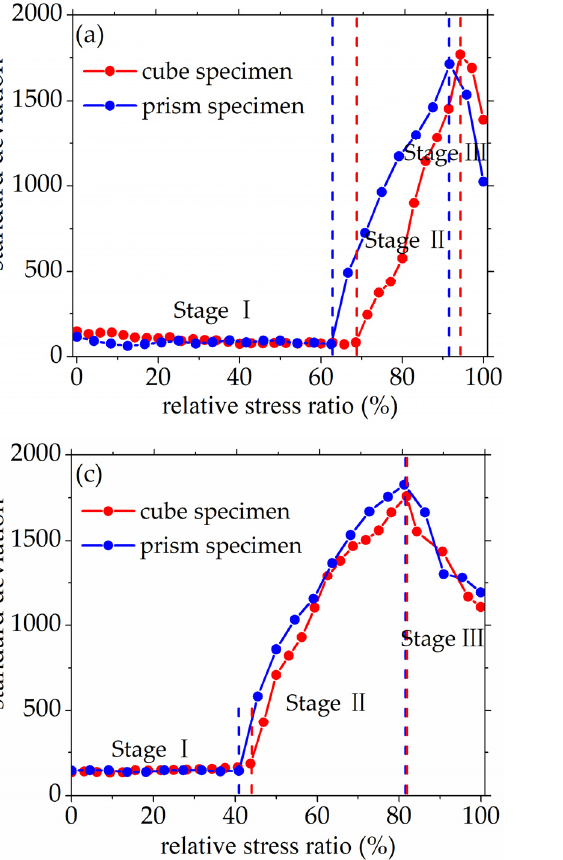
Figure 8. The standard deviations of AE elastic wave velocity for concrete with a different coarse aggregate volume fraction, ( a ) 0 %, ( b ) 20 %, ( c ) 40 %, ( d ) 60 %.